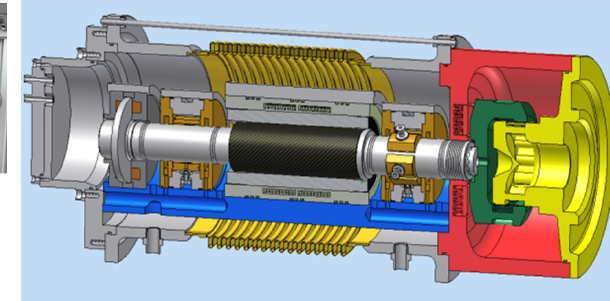
The rotor properties and the excitation forces used in the numerical model for rotor dynamic calculations are as fol- lows: